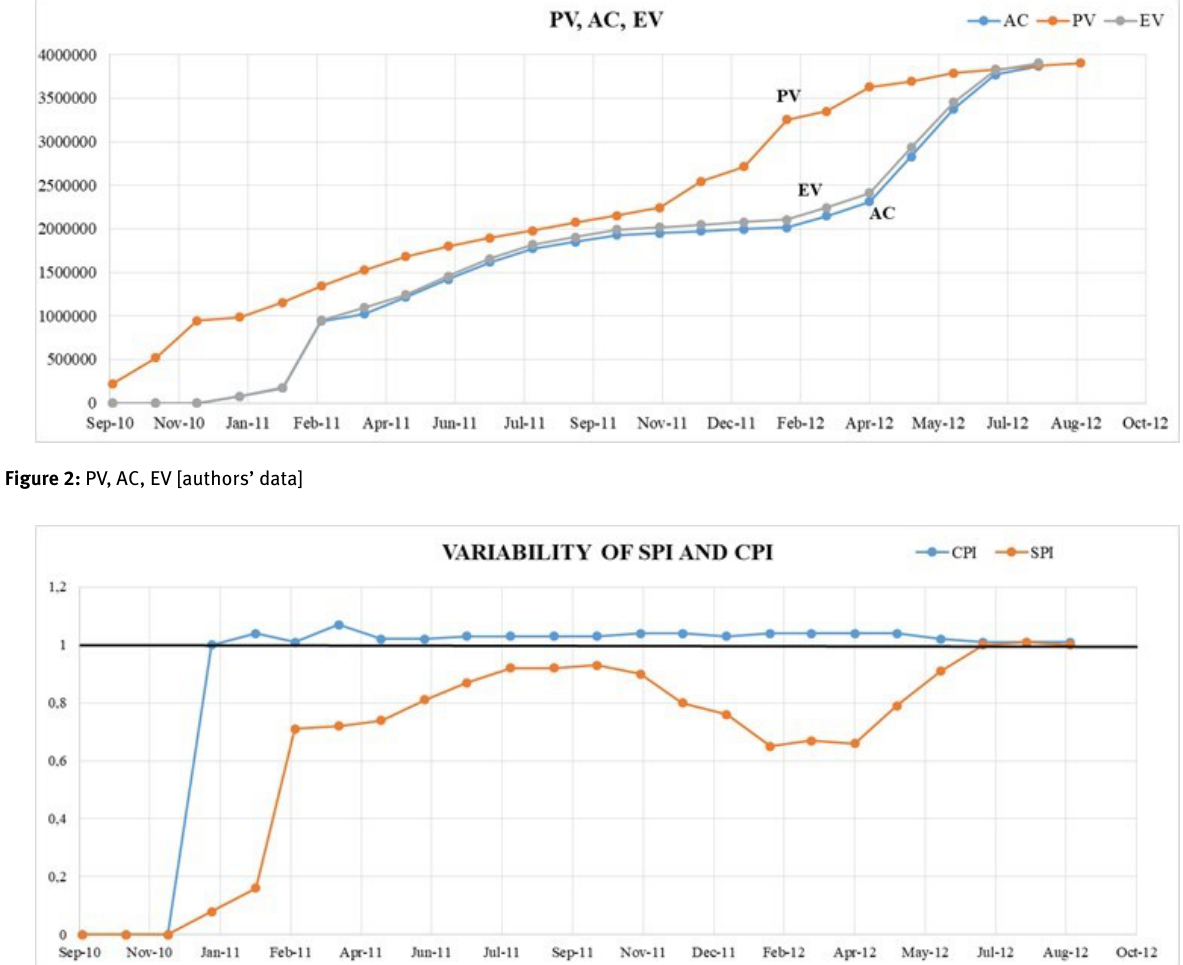
The final cost of the project was 3,868,319.55 PLN. This metric was lower by as much as 37,031.23 PLN from the ini- tially adopted cost of the work (BAC from October